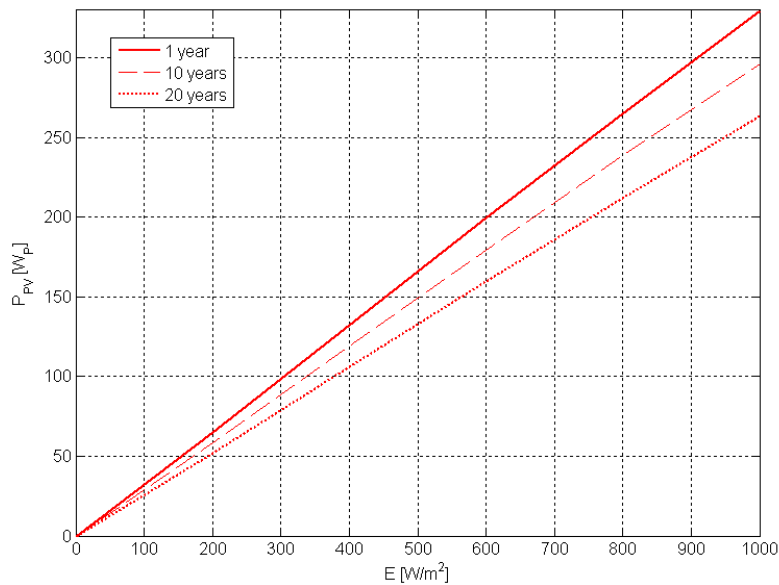
Figure 7. The influence of PV panel aging on P PV = f(E) [40].